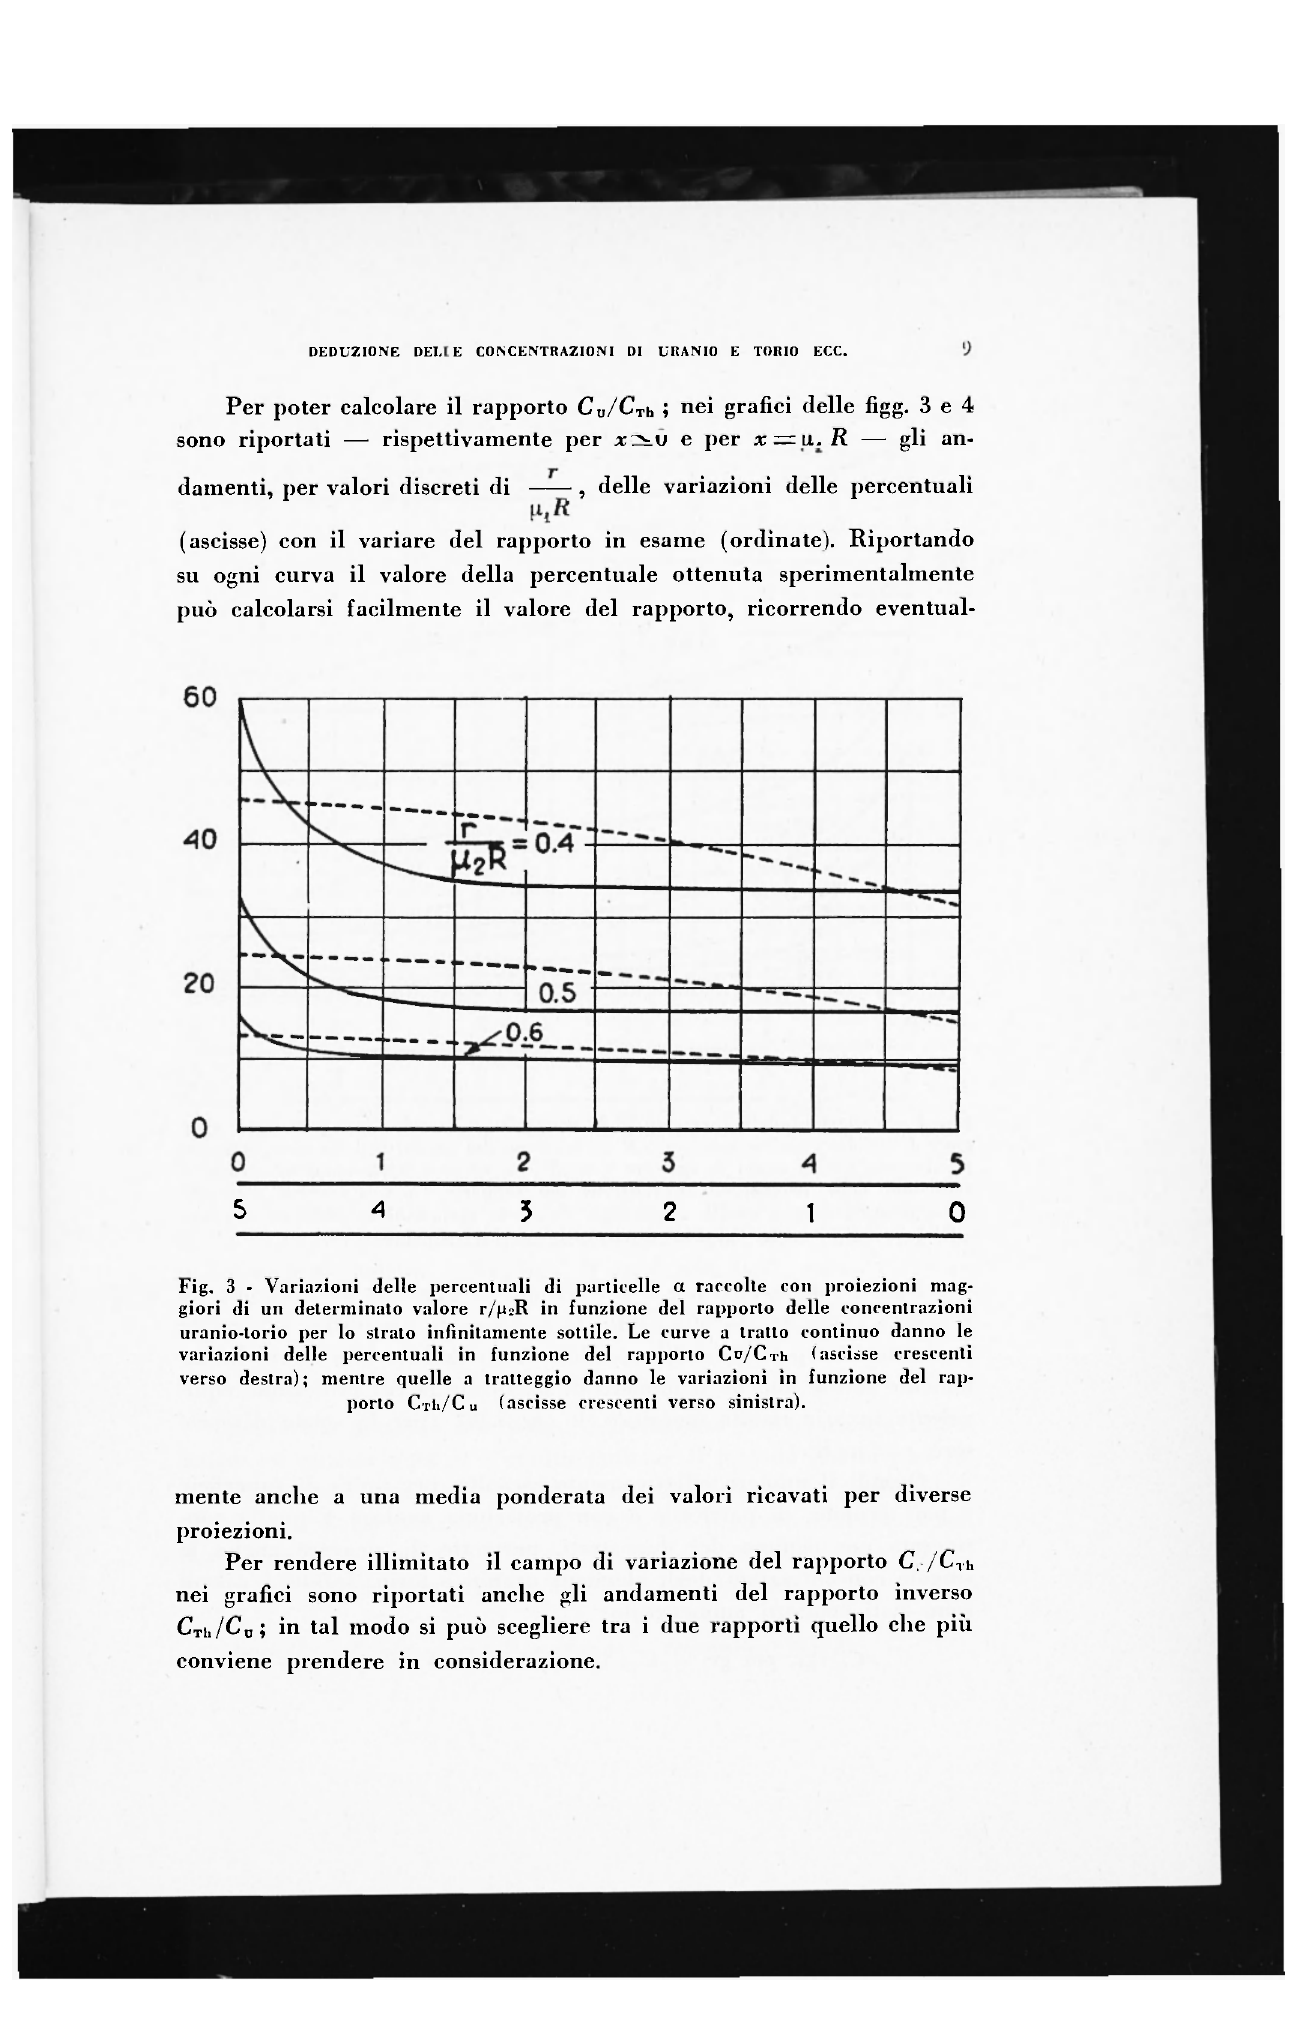
Fig. 3 - Variazioni delle percentuali di particelle a raccolte con proiezioni mag- giori di un determinalo valore r/^R in funzione del rapporto delle concentrazioni uranio-torio per lo strato infinitamente sottile. Le curve a tratto continuo danno le variazioni delle percentuali in funzione del rapporto Cv/Crìi (ascisse crescenti verso destra); mentre quelle a tratteggio danno le variazioni in funzione del rap- porto Cxh/Cu (ascisse crescenti verso